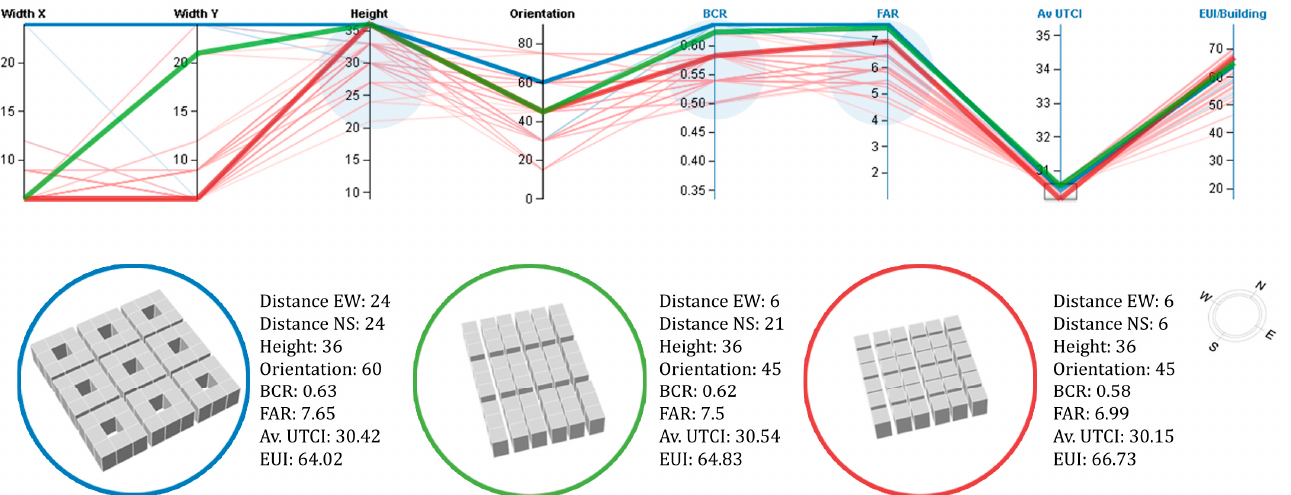
Figure 10. Parallel coordinates showing the selective cases for the minimum Av.UTCI.